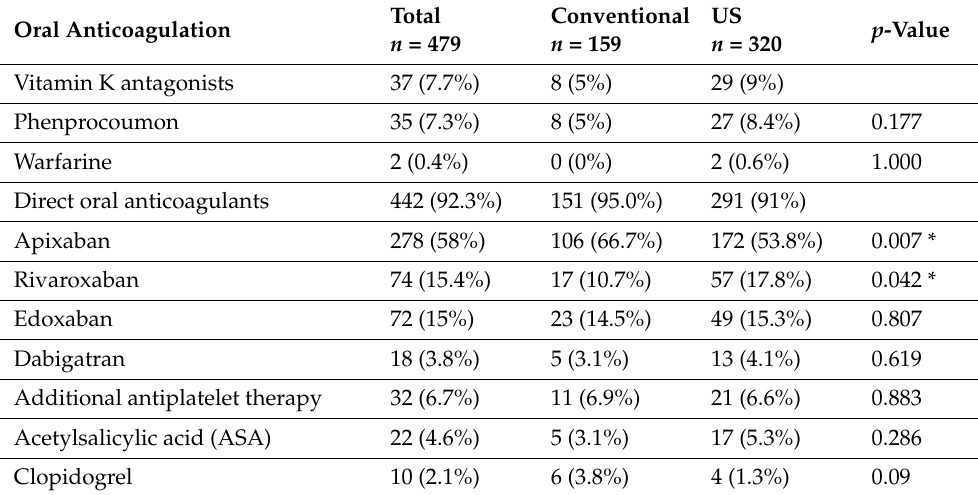
Table 3. Oral anticoagulation and antiplatelet agents before the procedure.